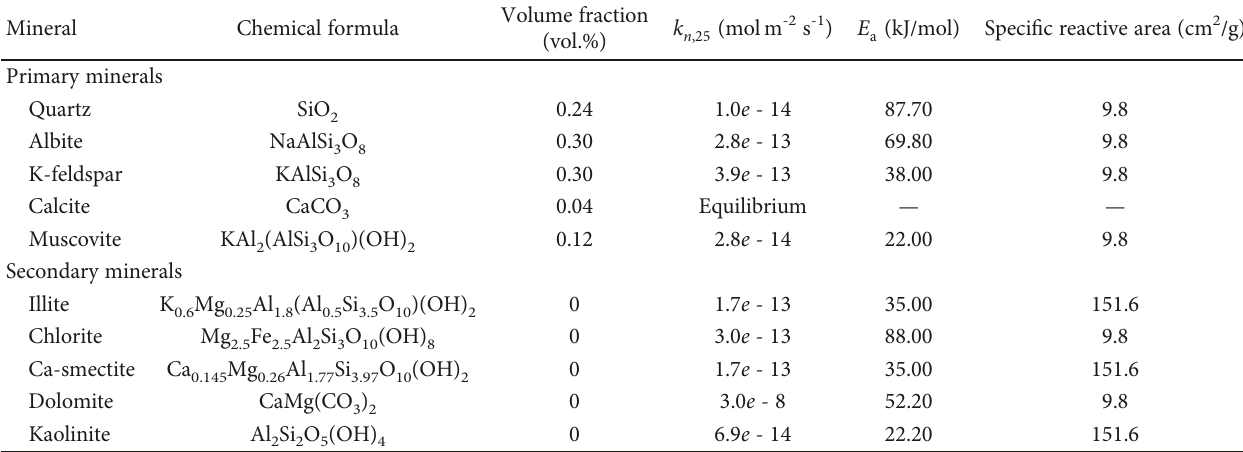
Table 3: Summary of primary and secondary minerals considered in the numerical simulation and their initial volume fractions, kinetic constants ( k ), activation energies ( E ), and speci fi c reactive areas. a n ,25 Mineral